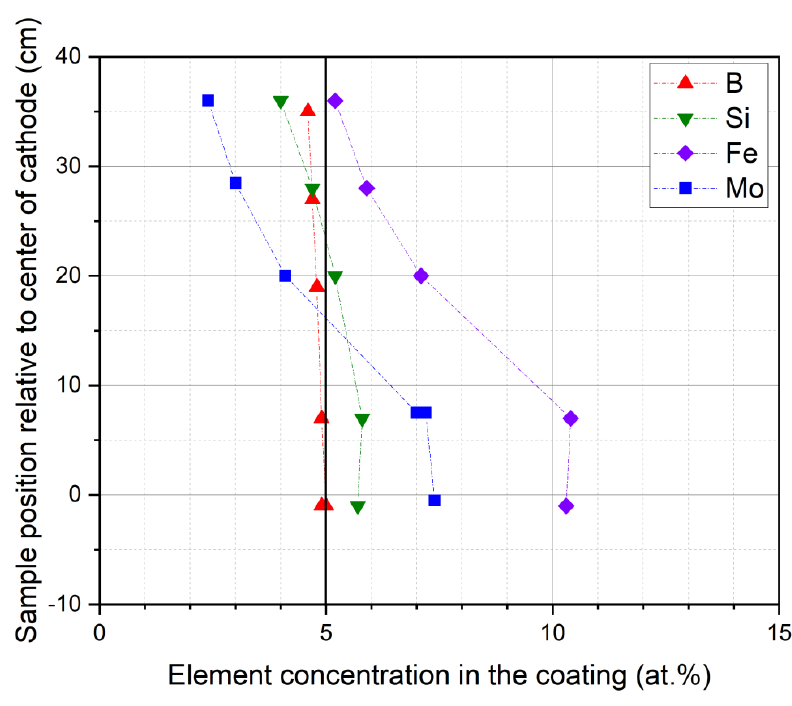
Figure 5. Element concentration over the vertical sample position relative to the center of the cathode; the nominal element concentration in the cathode is 5